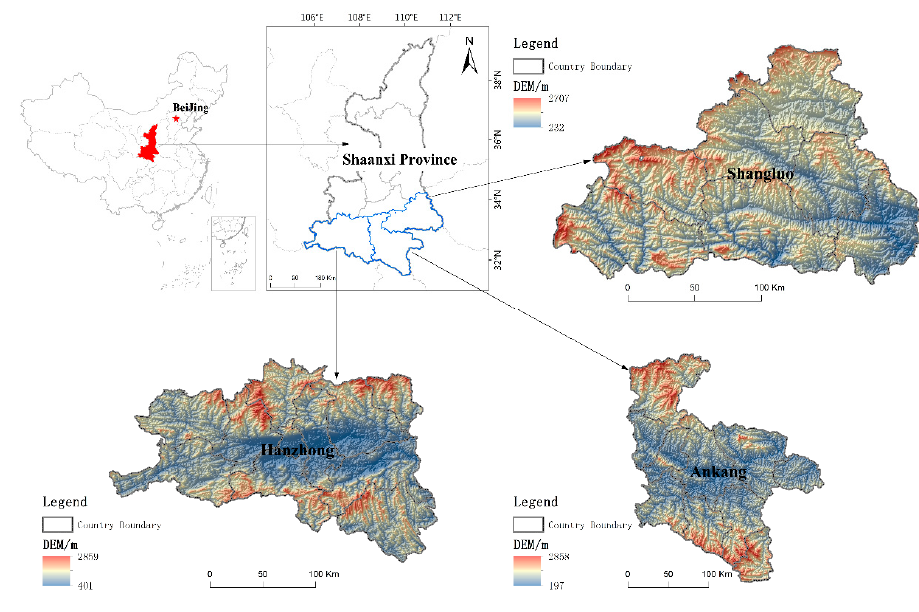
Figure 3. Area involved in the Resettlement of South Shaanxi (RSS).